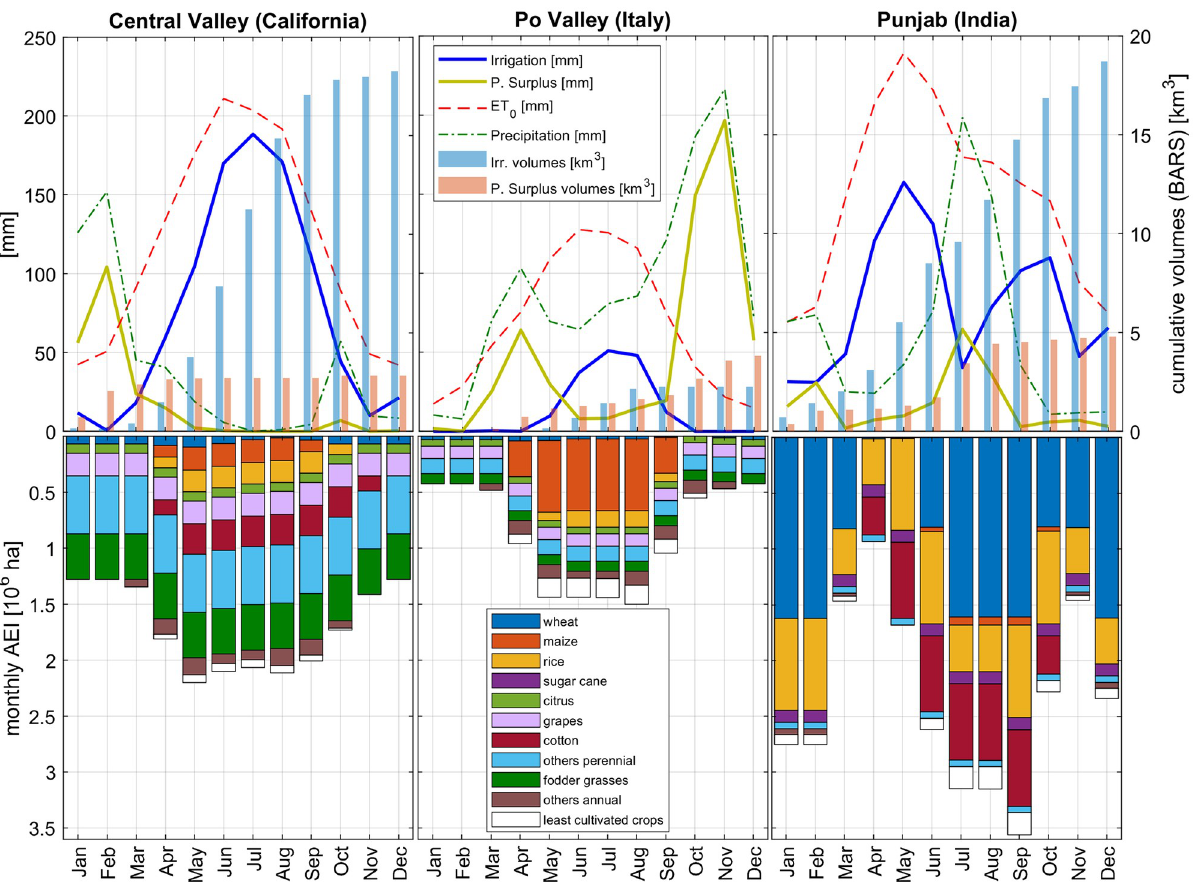
Fig 5. Monthly variability of climate forcings and model results, over three intensively harvested areas. The selected regions belong to different agro-climatic zones: Central Valley (California, sub-tropic winter rainfall), Po Valley (Italy, temperate sub-continental) and Punjab (India, sub-tropic summer rainfall). The variables on both the axes have been quantified considering the monthly harvested AEI , as shown in the lowest part of the